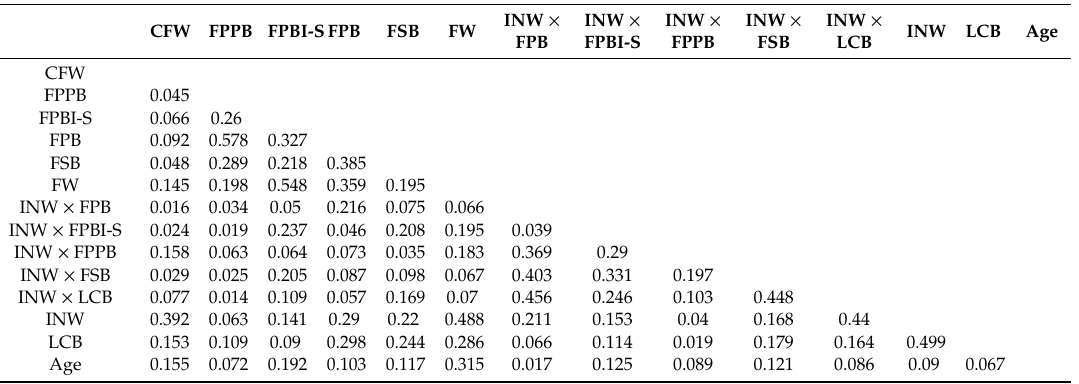
Table 5. Heterotrait-Monotrait